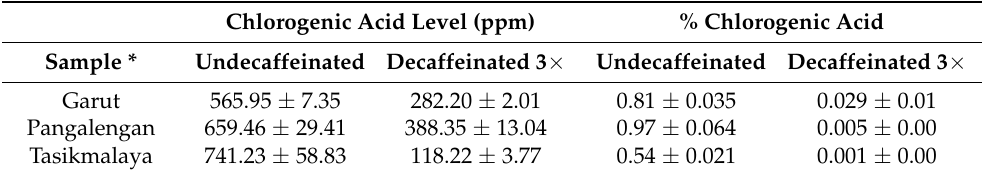
Table 3. Level of chlorogenic acid in coffee bean samples.